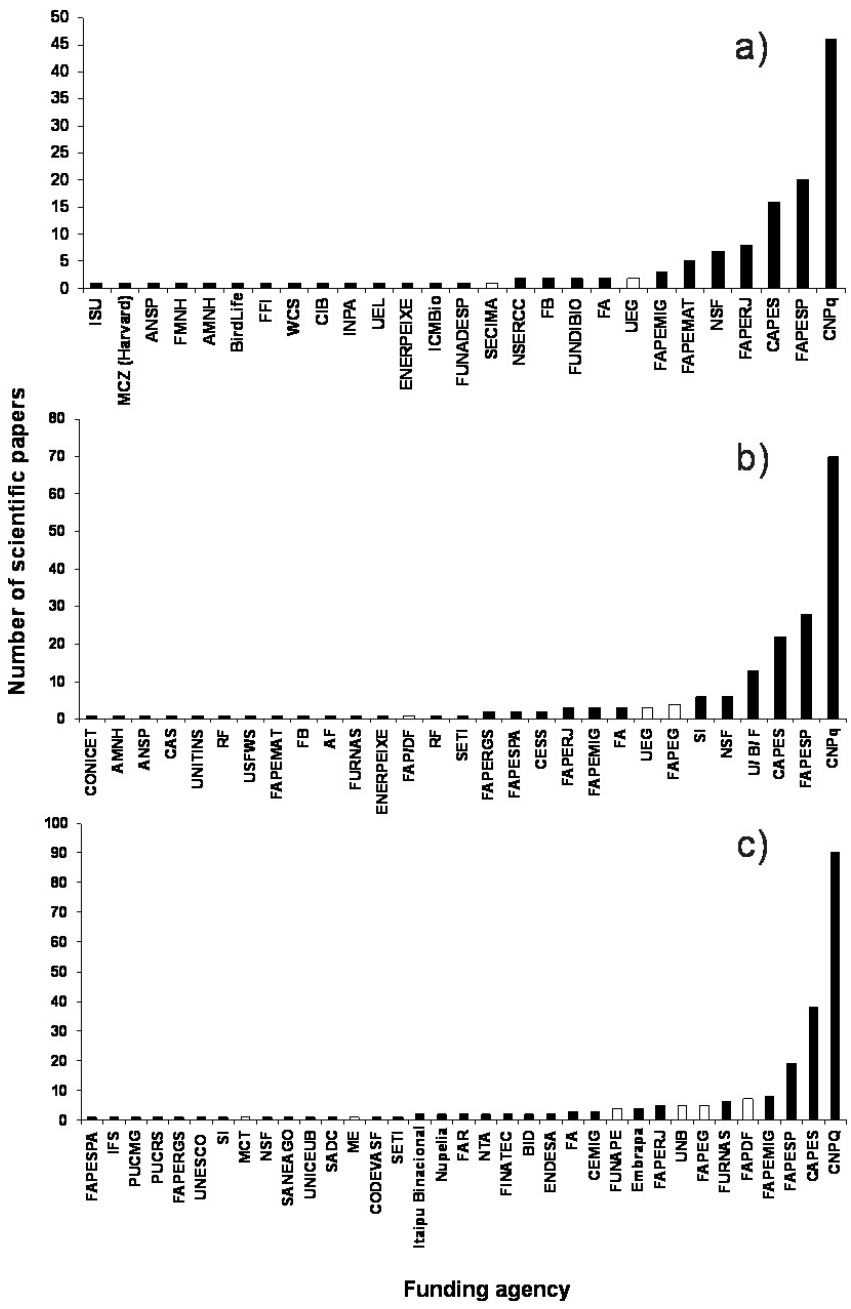
Figure 5. Number of scientific papers by funding agency’s grants in the Araguaia (a), Tocantins (b) and Paraná River basin (c). Funding agencies or institutions are identified according their location inside (white bars) or outside (black bars) Goiás